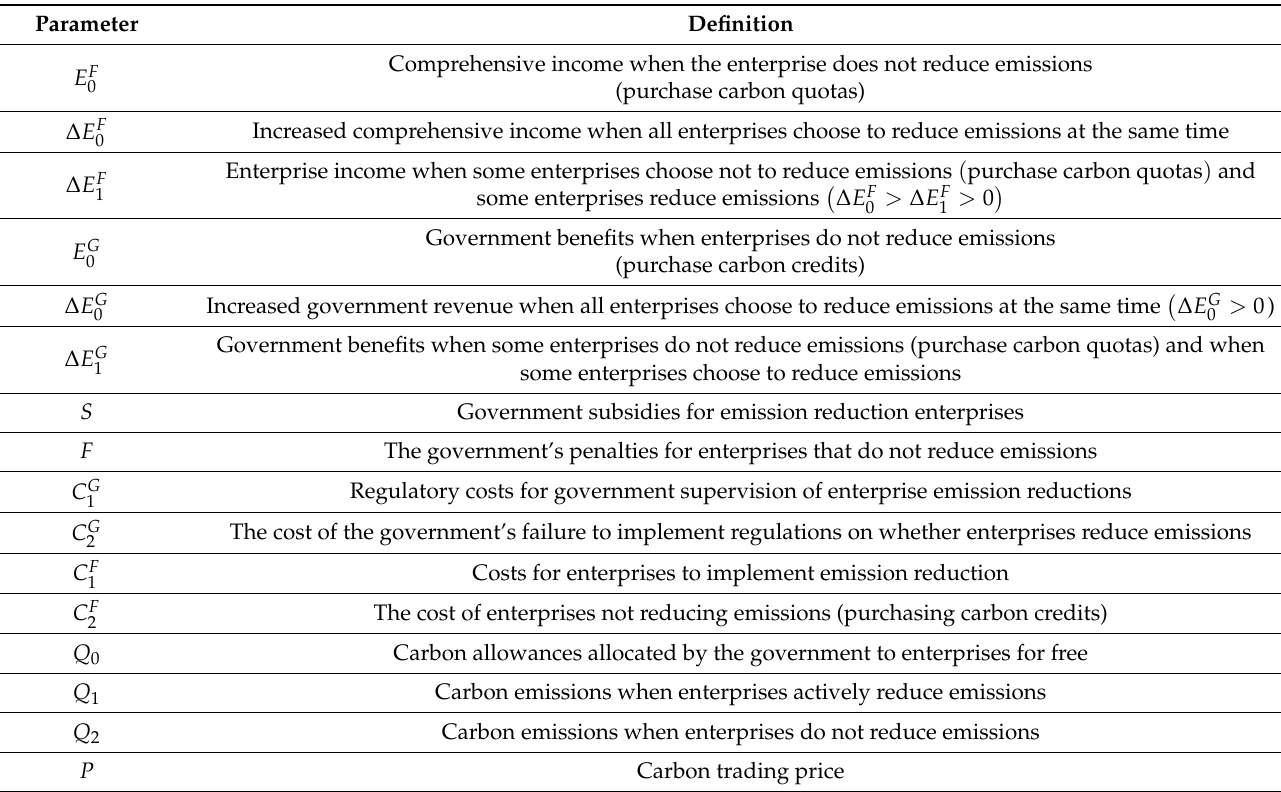
Table 1. Model parameters and